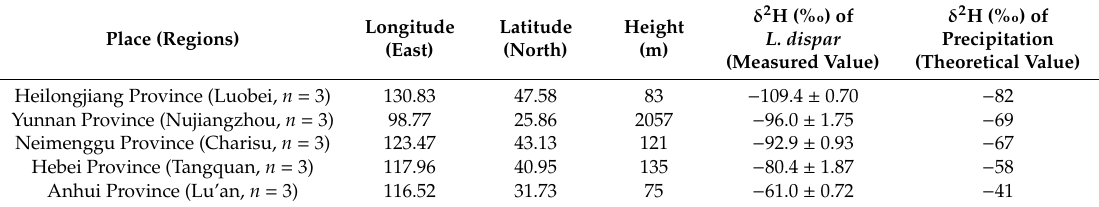
Table 1. δ 2 H value of L. dispar in the five studied geographical locations in China. Measured data are mean ± SD. n = 3 biological replicates.